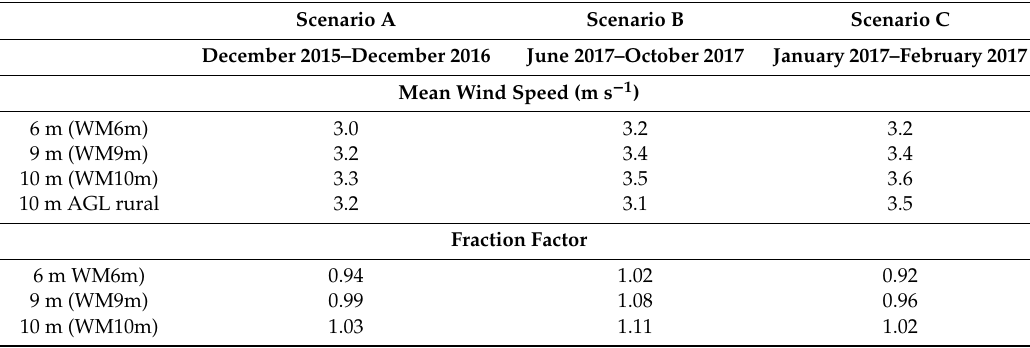
Table 3. Fraction of mean wind speed measured at WM 6 m, WM 9 m and WM 10 m (Figure 2) for scenarios A, B and C (represented by averages in the selected periods) to the 10 m AGL wind speed observed at the rural station